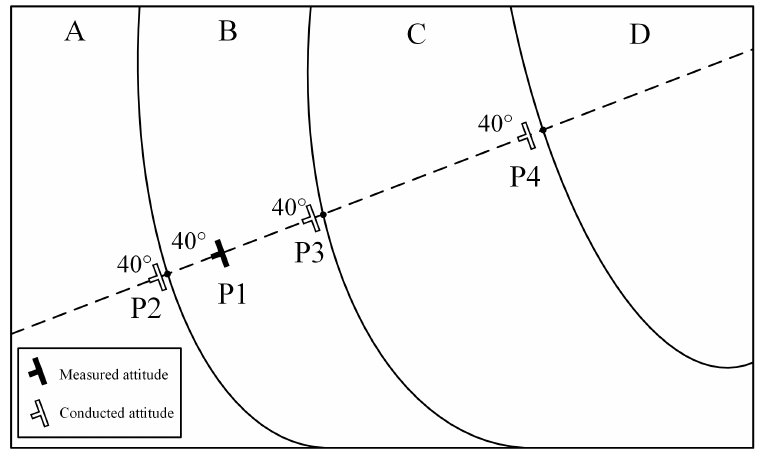
Figure 3. Schematic diagram of measured attitude conduction [11]. A, B, C, and D are four strata with an integrated contact relationship. Draw a straight line through the attitude point P1 along its inclination, and make the line intersects the stratigraphic boundary at points P2, P3, and P4, respectively.